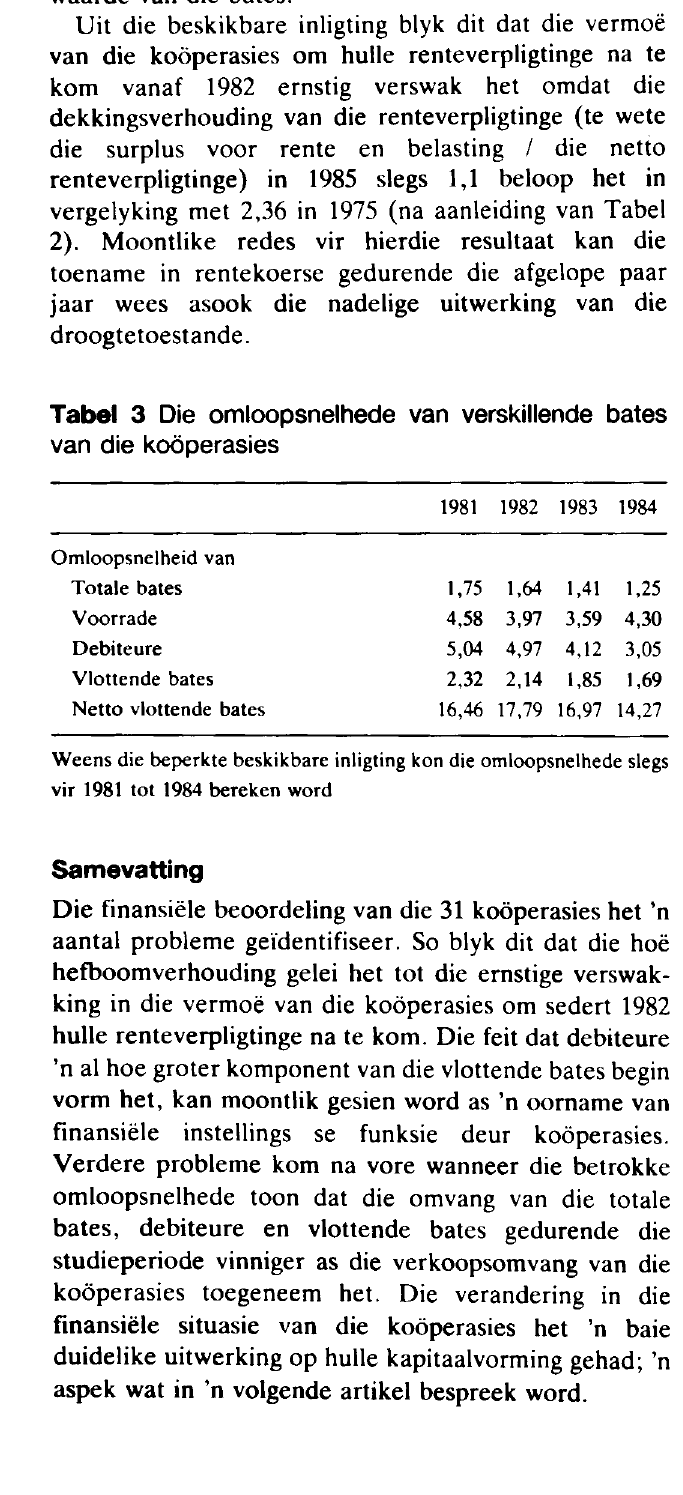
Tabet 3 Die omloopsnelhede van verskillende